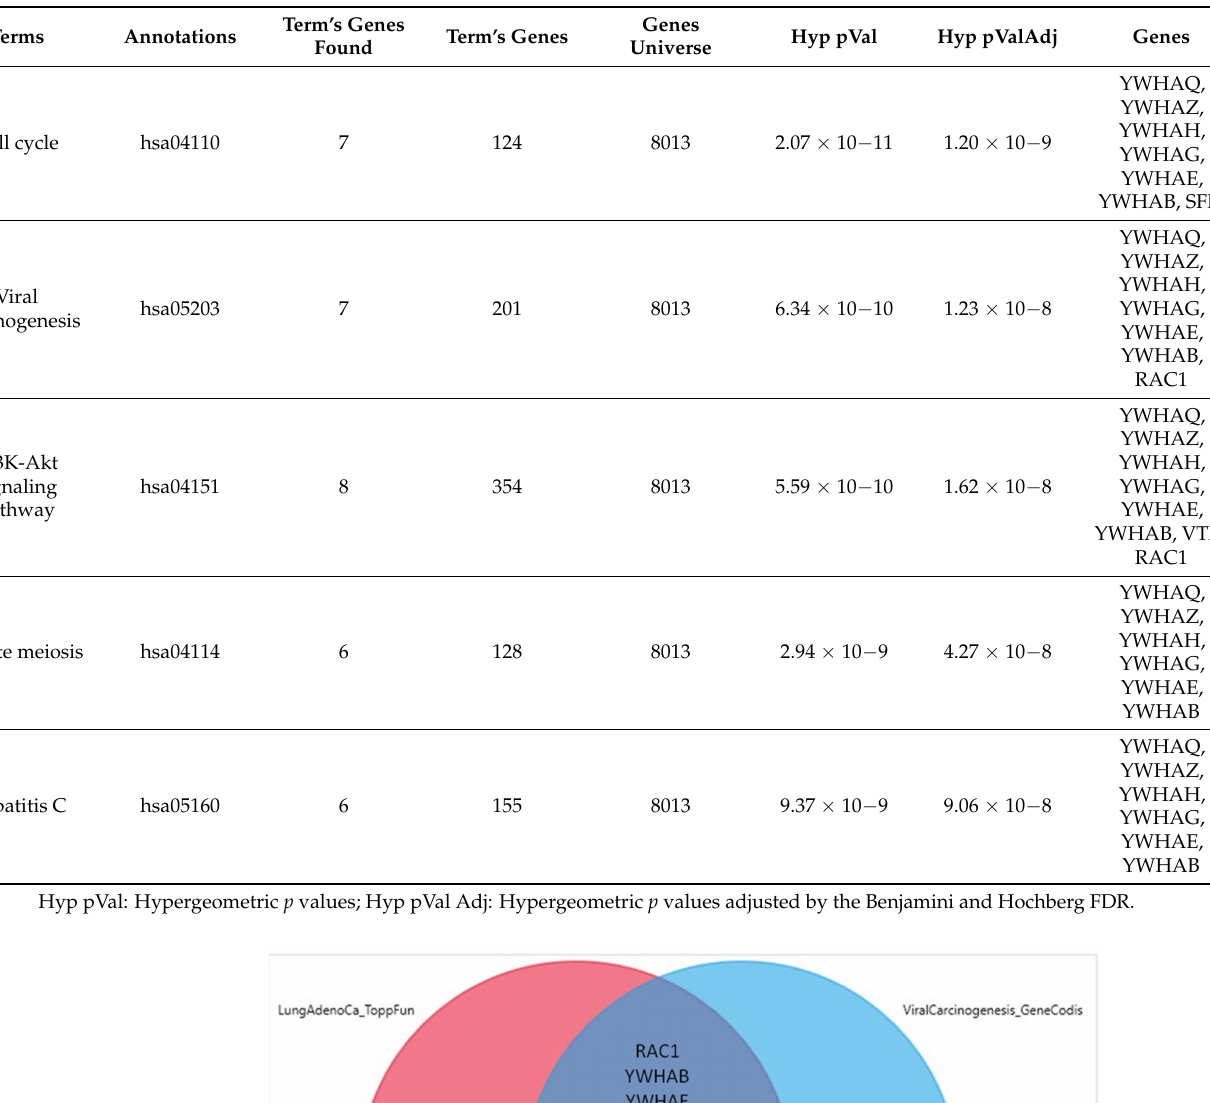
Table 8. The top 5 annotations identified by the GeneCodis FEA for KEGG pathways.